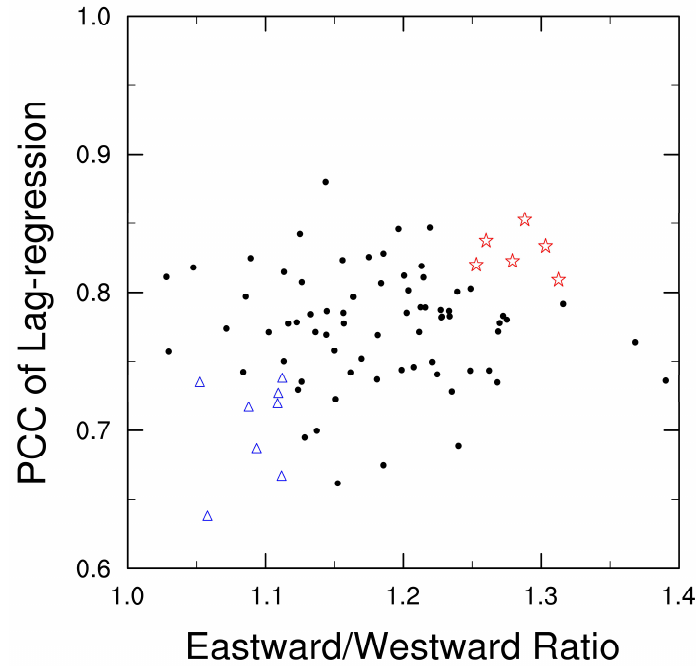
Figure 5. Scatter plots of scores by Lag-correlation (y axis) against scores by E / W ratio (x axis) with good (poor) simulations selected by the new evaluation strategy scattered in red stars (blue triangles) while the rest of 85 runs scattered in black dots.